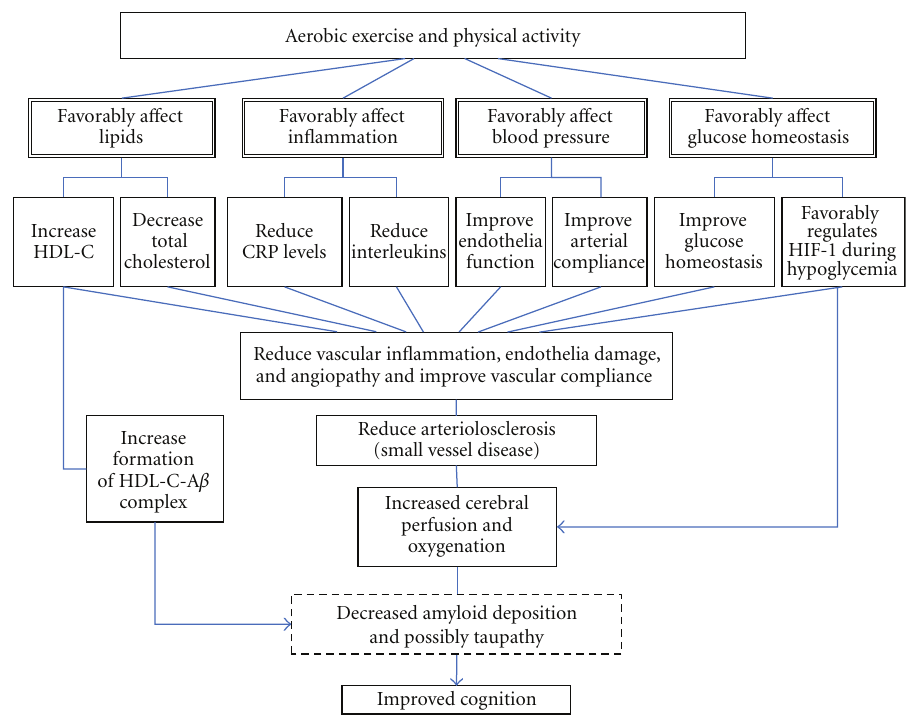
Figure 1: Aerobic exercise training and cognitive functions. Aerobic exercise increases HDL-C and subfractions; decrease total cholesterol, C- reactive protein, and interleukin-1; improves endothelia function and arterial compliance; improves glucose homeostasis and downregulates